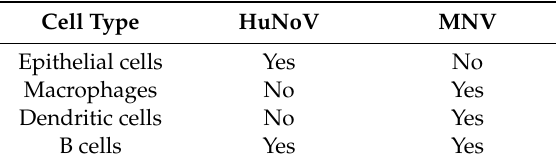
Table 3. Summary of cell types which support in vitro replication of HuNoV and